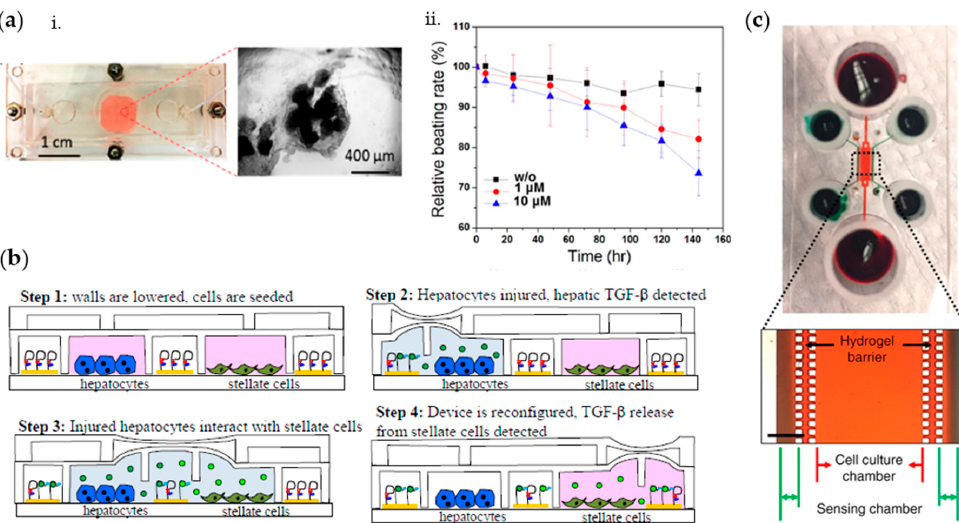
Figure 3 . ( a ) Photograph of the microfluidic bioreactor and the cardiac spheroids (i); measured normalized beating rates of cardiomyocytes over time after exposure to di ff erent concentrations (0, 1, normalized beating rates of cardiomyocytes over time after exposure to different concentrations (0, 1, and 10 µM) of doxorubicin (ii). Adapted from Ref. [91] with permission from ACS Publications. ( b ) and 10 µ M) of doxorubicin (ii). Adapted from Ref. [91] with permission from ACS